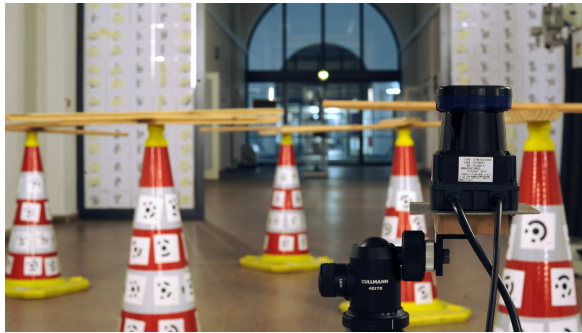
Figure 5: Measuring device Hokuyo UTM-30LX-EW in front of the target field.